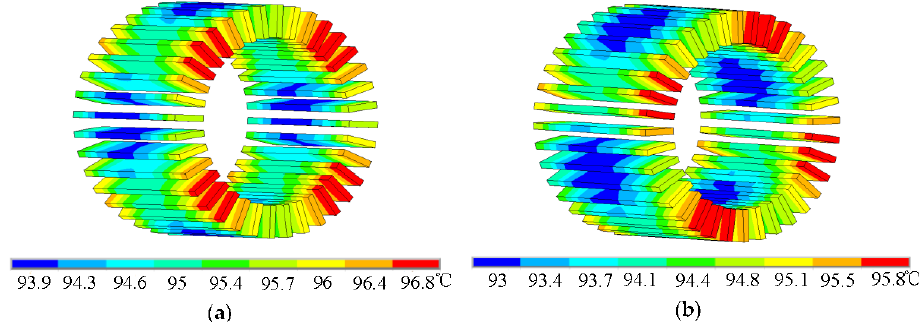
Figure 5. Temperature distribution of the stator winding before and after the proposed permanent magnet local maximum temperature suppressing method is applied: ( a ) Temperature distribution of the stator winding before the proposed permanent magnet local maximum temperature suppressing method is applied; ( b ) Temperature distribution of the stator winding after the proposed permanent magnet local maximum temperature suppressing method is applied.